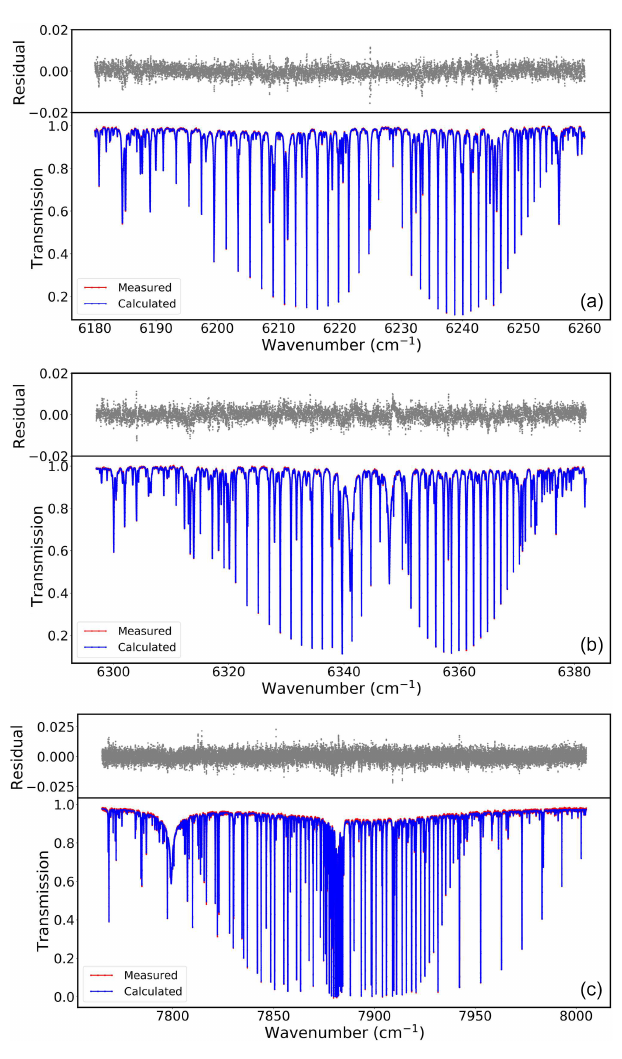
Figure 4. Measured and calculated spectrum of CO 2 in a spec- tral window of 6180–6260cm − 1 (a) , CO 2 in a spectral window of 6297–6382cm − 1 (b) and O 2 in spectral window of 7765– 8005cm − 1 (c)